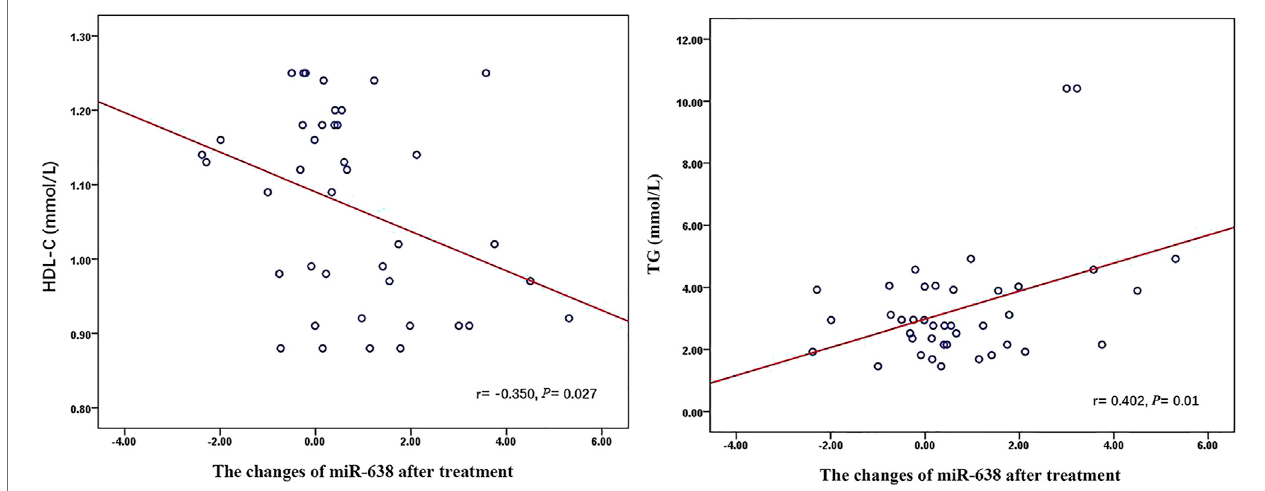
FIGURE 3 | The relationship between miR-638 and Lipid Pro fi les after XZK treatment. The changes of miR-638 were negatively correlated with baseline HDL-C levels ( r (cid:2) − 0.350, p (cid:2) 0.027). Conversely, the changes of miR-638 correlated positively with baseline triglyceride (TG) levels ( r (cid:2) 0.402, p (cid:2) 0.01).